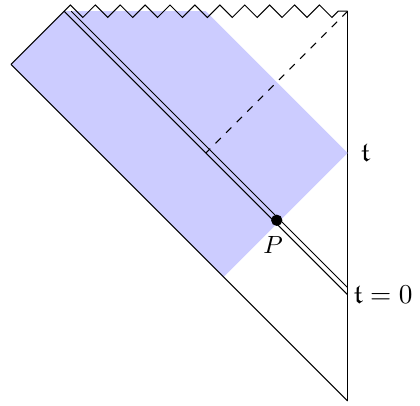
Figure 1 . The Penrose diagram of the time dependent geometry as a result of a collapse of a null shell (shown as a double line). The dashed line is the event horizon, and the shaded region denotes the WdW patch corresponding to boundary time t . The intersection of the past null boundary of the WdW patch and the collapsing null shell is denoted by a black dot and is labeled by P